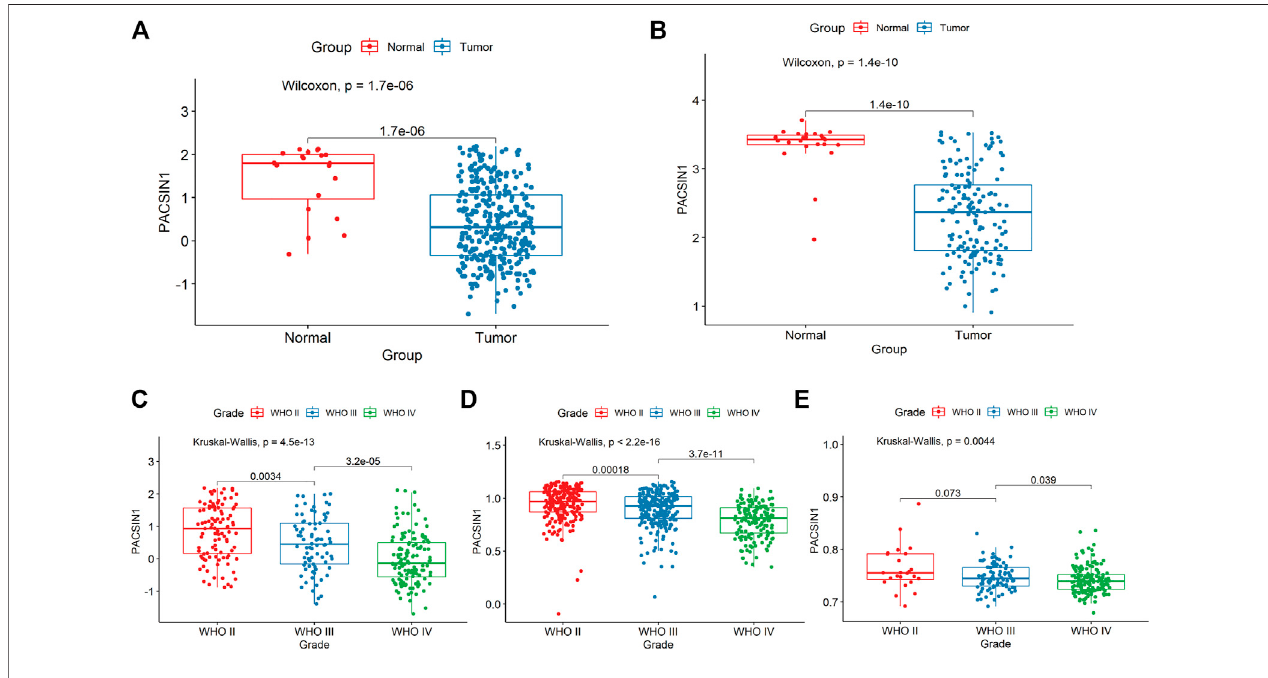
FIGURE 1 | PACSIN1 expression in glioma group and normal group and in different grades. PACSIN1 expression was lower in tumor group and higher in normal group in CGGA (A) and GEO4290 datasets (B) . PACSIN1 expression decreased with the increase of grades in CGGA (C) , TCGA (D) and GSE 16011 datasets (E) .